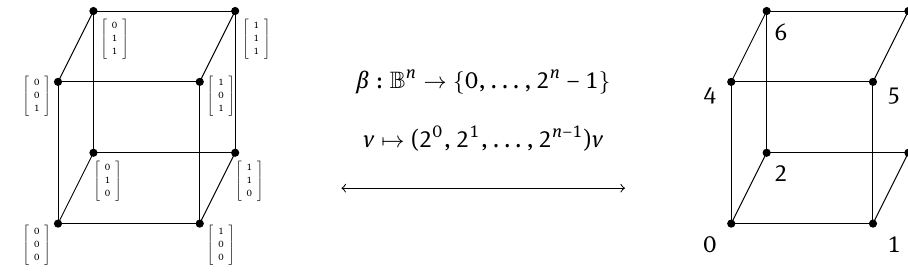
Figure 5: Binary-to-decimal numbering β of the vertex set B n of I n , depicted for n = 3